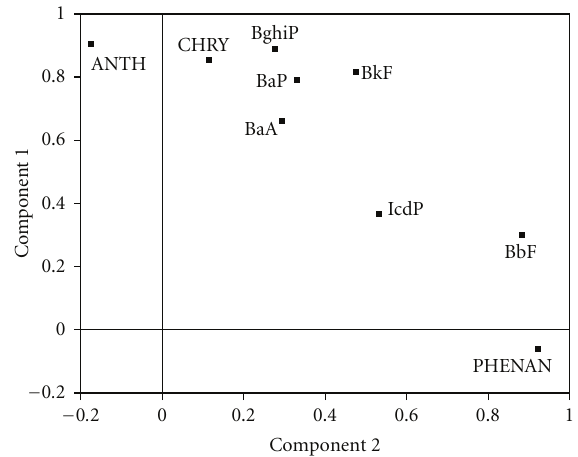
Figure 3: Factor analysis for PAH concentration in Coimbatore